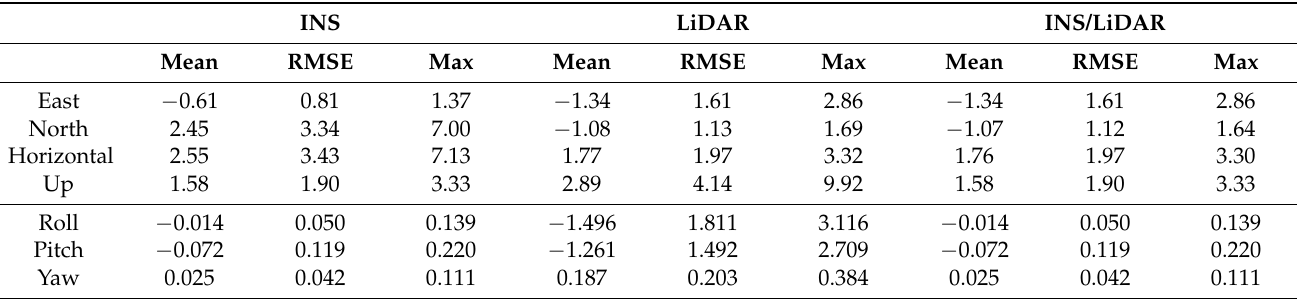
Table A20. D-16—position (m) and attitude (deg) error statistics.